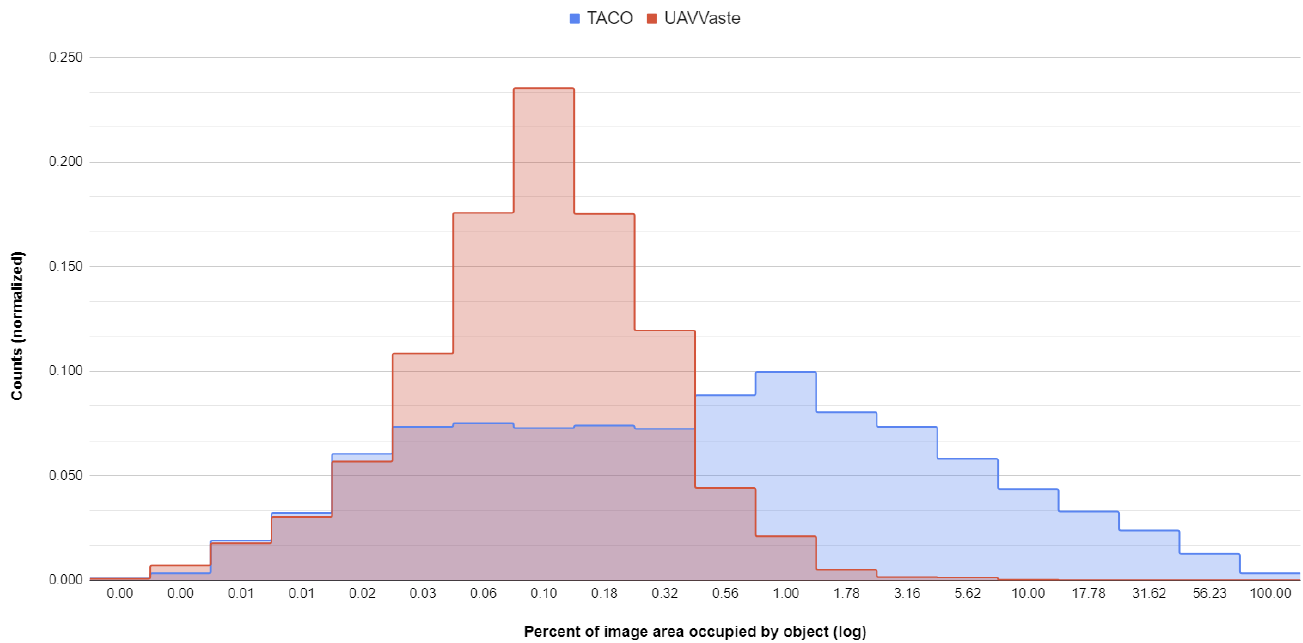
Figure 1. Comparison of relative object size distributions in the TACO and UAVVwaste datasets—Normalized counts versus percent of image occupied by objects. Please note the log-scale on the horizontal